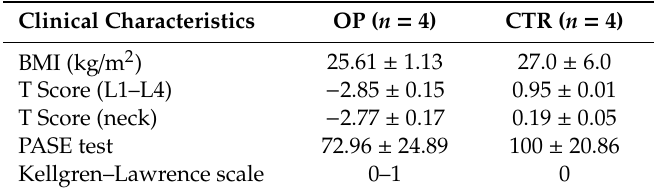
Table 1. Main characteristics of osteoporosis (OP) patients and control (CTR) individuals.